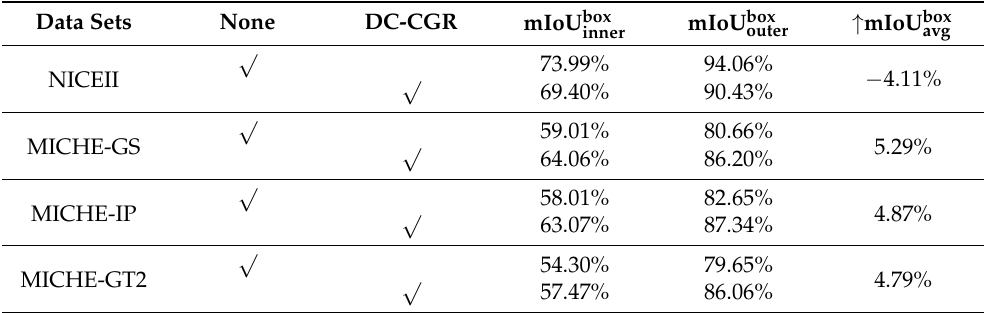
Table 1. Ablation study of concentric sampling. “ ↑ ” denotes the improvement of localization performance after using concentric sampling strategy to auxiliary